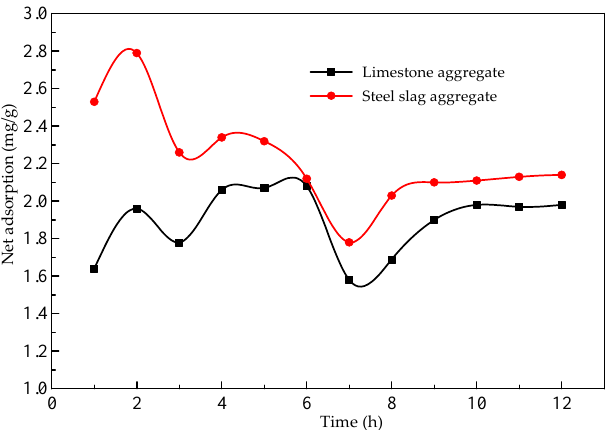
Figure 9. Relationship between net asphalt adsorption capacity and adsorption time.